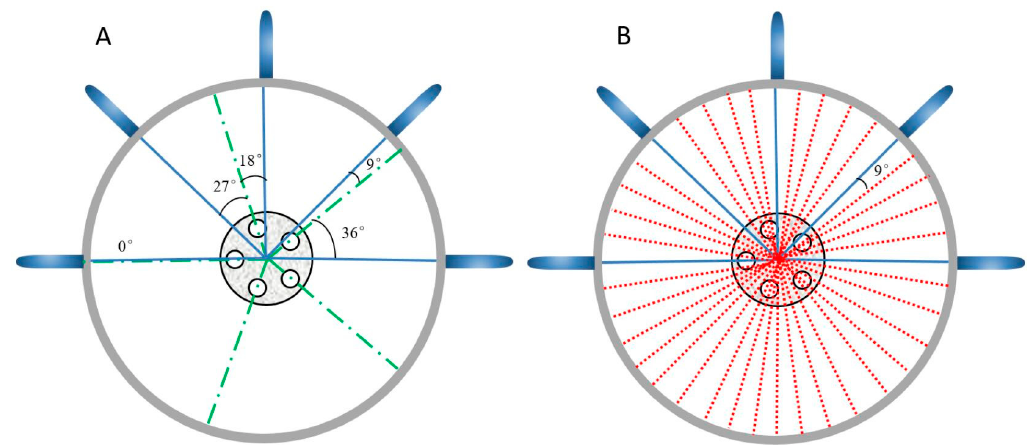
Figure 2. Arrangement mode and symmetric relation of the sampling positions. ( A ). position of the sampling hole and the oxygen lance nozzle; ( B ). schematic diagram of the calculation method with the symmetry.